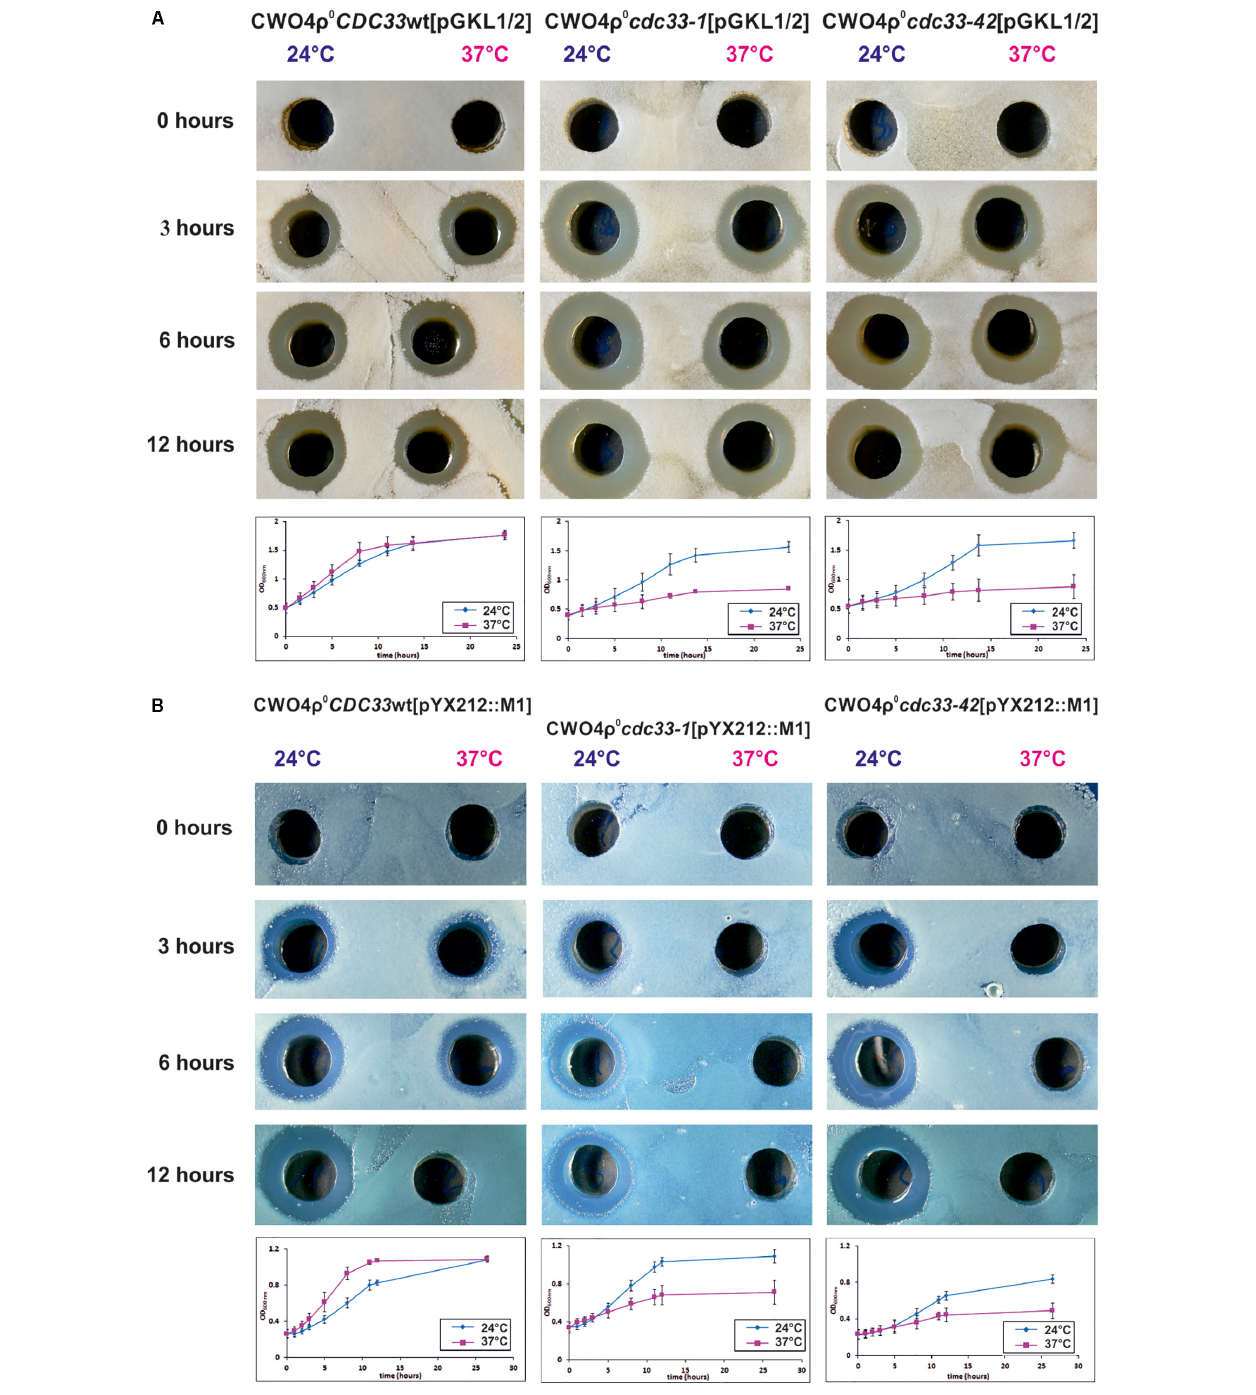
FIGURE 10 | The killer toxin encoded by pGKL VLEs is synthesized by the eIF4E-independent pathway. (A) Production of pGKL killer toxin in S. cerevisiae CWO4 ρ 0 strains bearing cytoplasmic pGKL VLEs and different CDC33 alleles. The pGKL toxin-coding mRNAs do not contain 3 (cid:48) poly(A) tails and are mostly 5 (cid:48) uncapped and 5 (cid:48) polyadenylated ( Supplementary Tables S4, S5A and Figure 6 ). (B) Production of K1 killer toxin in control S. cerevisiae CWO4 ρ 0 strains containing pYX212::M1 plasmid and different CDC33 alleles. The control mRNA coding for K1 toxin is transcribed in the nucleus by RNA polymerase II. In both cases, the results are shown for S. cerevisiae CWO4 ρ 0 strains bearing either the wild-type CDC33 (eIF4E) gene ( CDC33 wt) or temperature-sensitive mutations in the CDC33 (eIF4E) gene ( cdc33-1 and cdc33-42 alleles) grown under both permissive (24 ◦ C) and non-permissive (37 ◦ C) conditions. Aliquots were taken at 0, 3, 6, and 12 h, and the culture medium was filter sterilized, diluted 10 × , and assayed for killer toxin activity by an agar well diffusion test using a lawn of S. cerevisiae S6/1 sensitive strain cells. Growth curves of all strains at the permissive (blue) and non-permissive (purple) temperatures are shown below each of the corresponding sets of killer toxin experiments. Each growth curve represents at least three independent experiments. Error bars correspond to standard deviation.